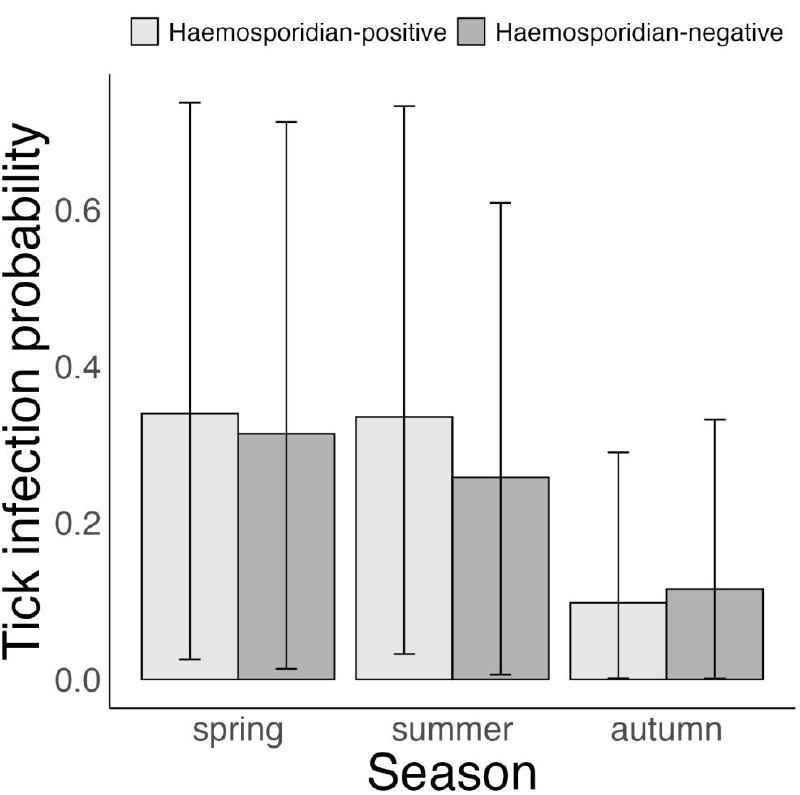
Figure 4. Bayesian Bernoulli distribution model on variation in the probability of Borrelia -infection of bird-feeding Ixodes ricinus ticks per host according to haemosporidian infection status of 5 avian host species in Slovakia, 2017 – 2019. Displayed are posterior means and 95% CrI.